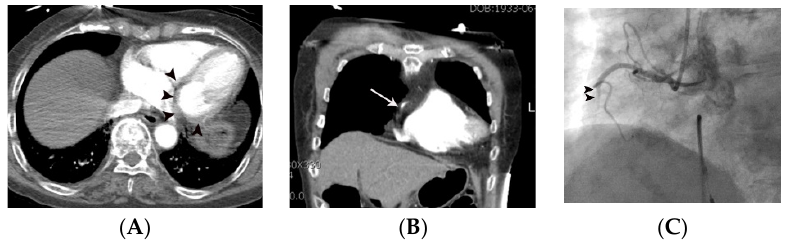
tery was confirmed on subsequent coronary angiography (arrow in E ).